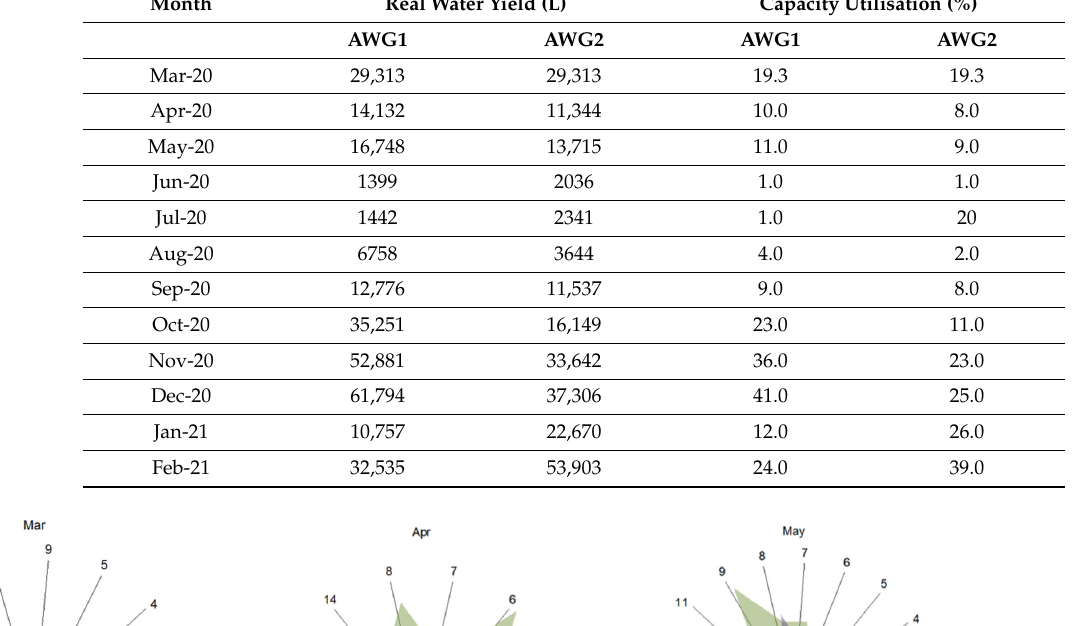
Table 2. Performance of the AWGs under ECS. Real Water Yield (L)